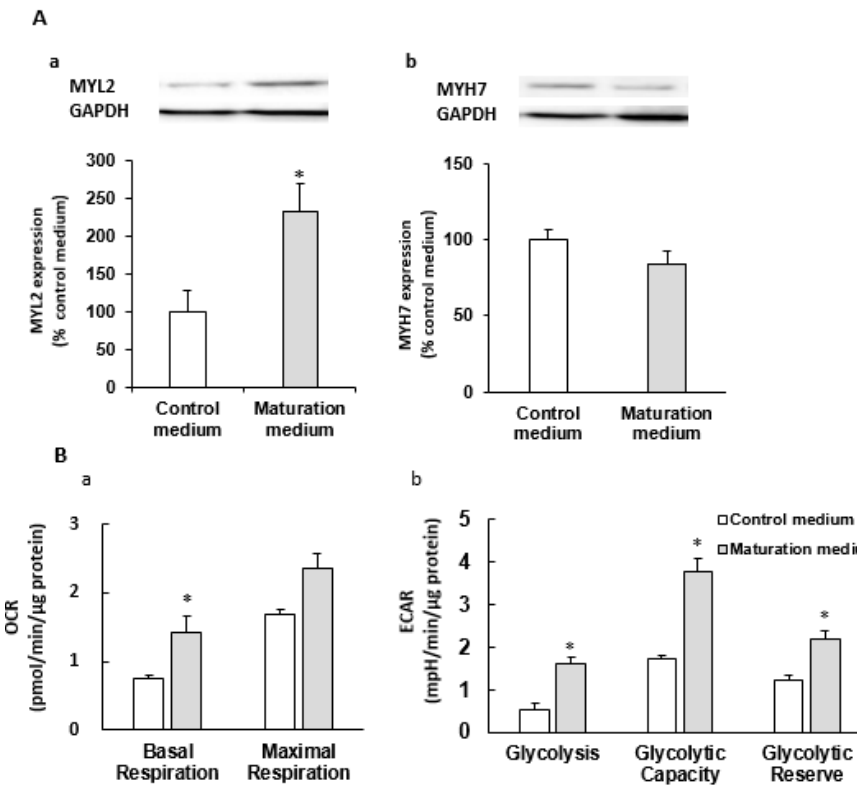
Figure 7. The e ff ect of the maturation medium on protein expression, and metabolism of H3083 iPSC-derived CMs ( A ) Western blot analysis of the e ff ect of maturation medium treatment for 7 days on the expression of MYL2 and MYH7 proteins in iPSC-CMs (day 38). n = 4 * p < 0.05, vs. control medium. ( B ) The e ff ect of maturation medium on OCR and ECAR of iPSC-CMs (day 34). * p < 0.05 vs. control medium.